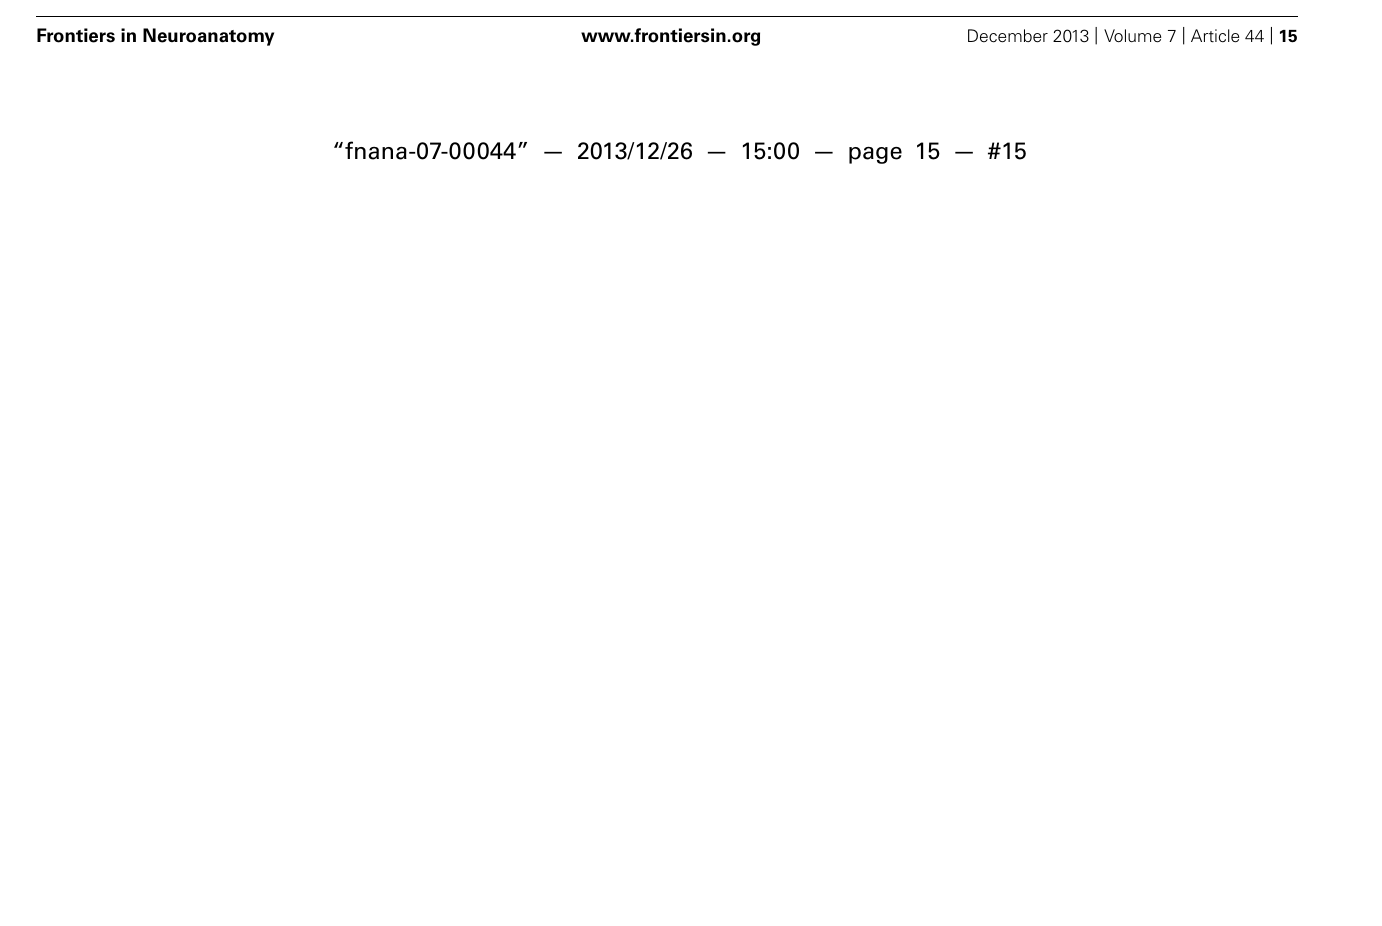
FIGURE 11 | (A–D) Treatment with CNTF and C16 reduced the expression of the pro-inflammatory cytokines IFN- γ but no evident effects on the expression of anti-inflammatory cytokine TGF- β . (A,B) TGF-b levels in plasma samples from different groups at weeks 2 (A) and 8 (B) post-immunization, as measured by ELISA. (C,D) IFN- γ levels in plasma samples from different groups at weeks 2 (A) and 8 (D) post-immunization, as measured by ELISA. a P < 0.05 versus the normal